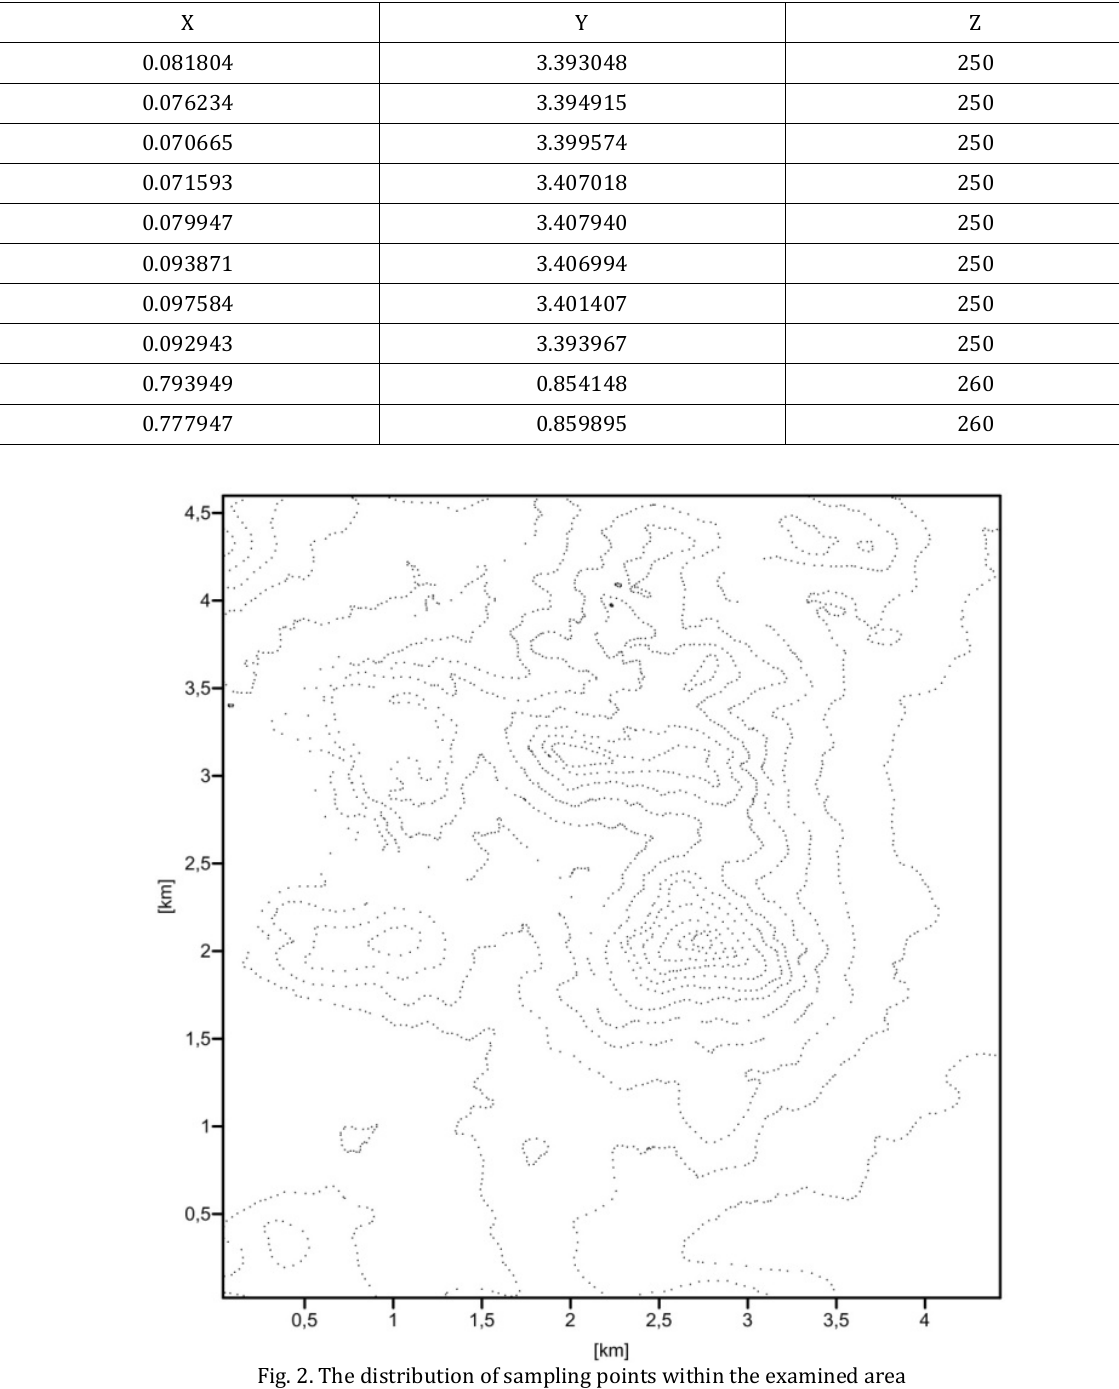
Fig. 2. The distribution of sampling points within the examined area